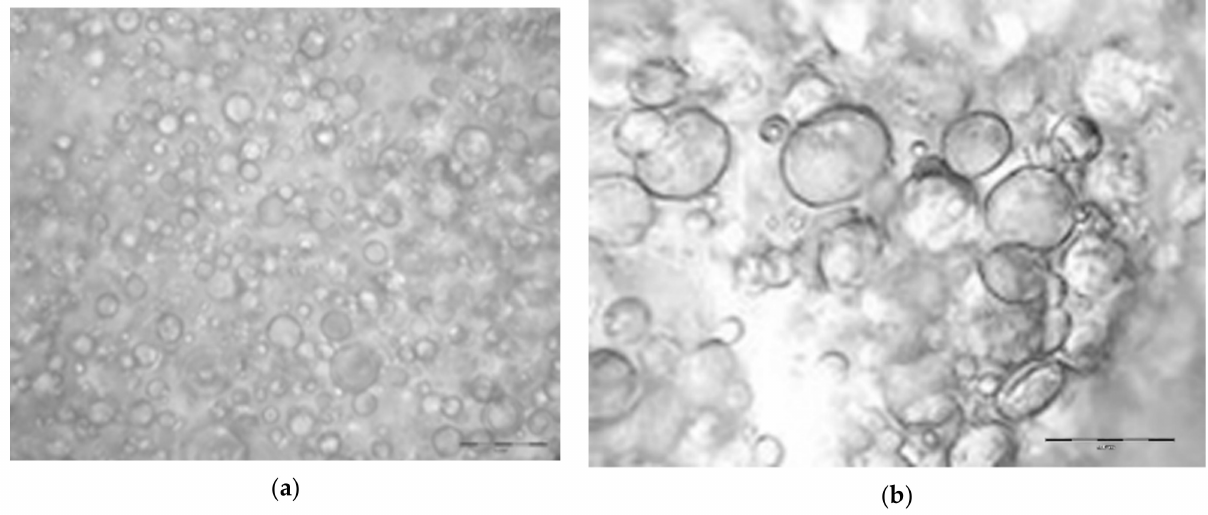
Figure 6. ( a ) Microscopic image of OW emulsion droplets (under 20 × light microscopy magnitude, scale represents 100 µ M). ( b ) SB oil droplets in calcium-crosslinked AGX hydrogel bead (under 20 × light microscopy magnitude, scale represents 100 µ